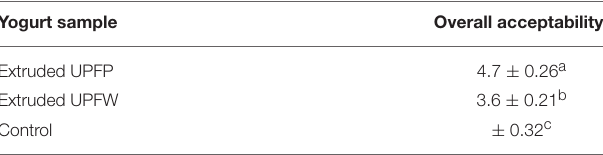
TABLE 5 | Sensory evaluation of yogurt added with extruded flours of unripe plantain pulp (UPFP) and whole fruit